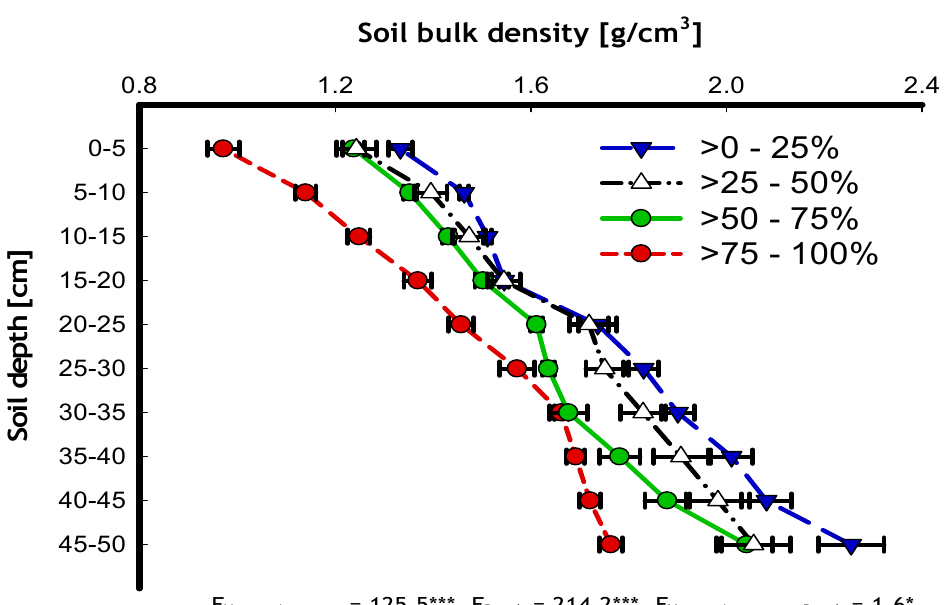
Figure 2. Distribution of soil bulk density [g/cm 3 ] in relation to soil depth [cm] in ten sites represent ten sabkhas with different vegetation covers along the southern Red Sea coast of Saudi Arabia. Horizontal bars indicate the standard errors of the means; F -values represent the two-way analysis of variance (ANOVA); Vegetation cover: 0—25%, >25—50%, >50—75% and >75—100%; Depth: 0—5, 5—10, 10—15, 15—20, 20—25, 25—30, 30—35, 35—40, 40—45 and 45—50 cm; *: p < 0.05; ***: p < 0.001; n = 30 for vegetation cover >25—50 and >75—100%; n = 32 for vegetation cover 0—25%; n = 33 for vegetation cover